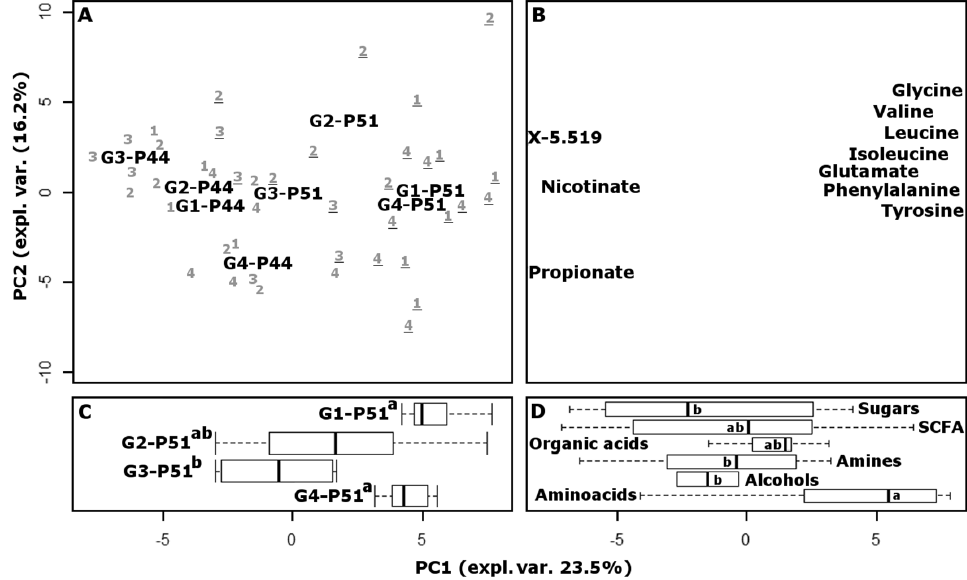
Figure 3. Score plot ( A ) of a PCA analysis of fecal metabolome. To facilitate the visualization of the differences of the samples at P51, their scores along PC1 are summarized by boxplots ( C ); Corresponding loading plot ( B ), in which only the 10 most important variables, as calculated by sPCA, are reported. The 81 loadings are also summarized by the molecular group in panel ( D ). In panels ( C , D ), different lowercase letters indicate statistically different groups ( p < 0.05). (G1, G2, G3, G4 refer respectively to the groups fed with: microencapsulated iron bread (FeMB ‐ G1); bread containing the same quantity of iron sulphate; starch and citric acid (FeSB ‐ G2); control bread (CB ‐ G3), and control bread with IM iron supplements at P5 (CB ‐ G4)).